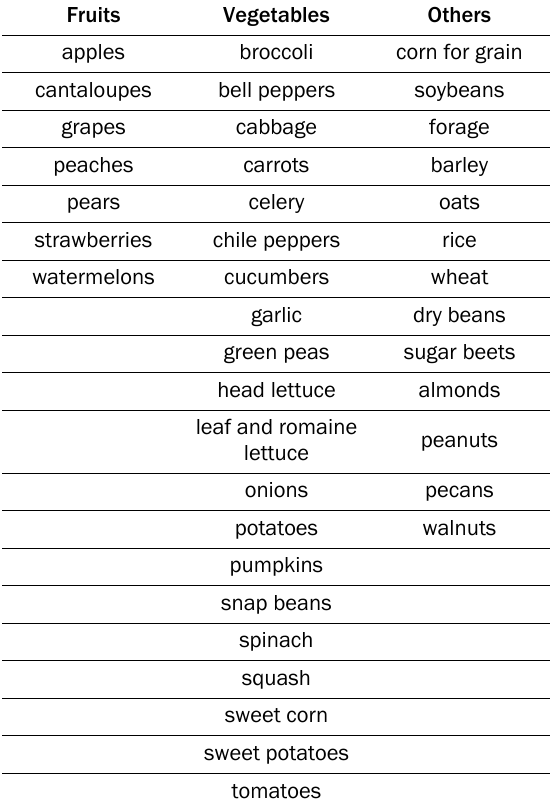
Table 2. Representative Crops Used To Determine Production